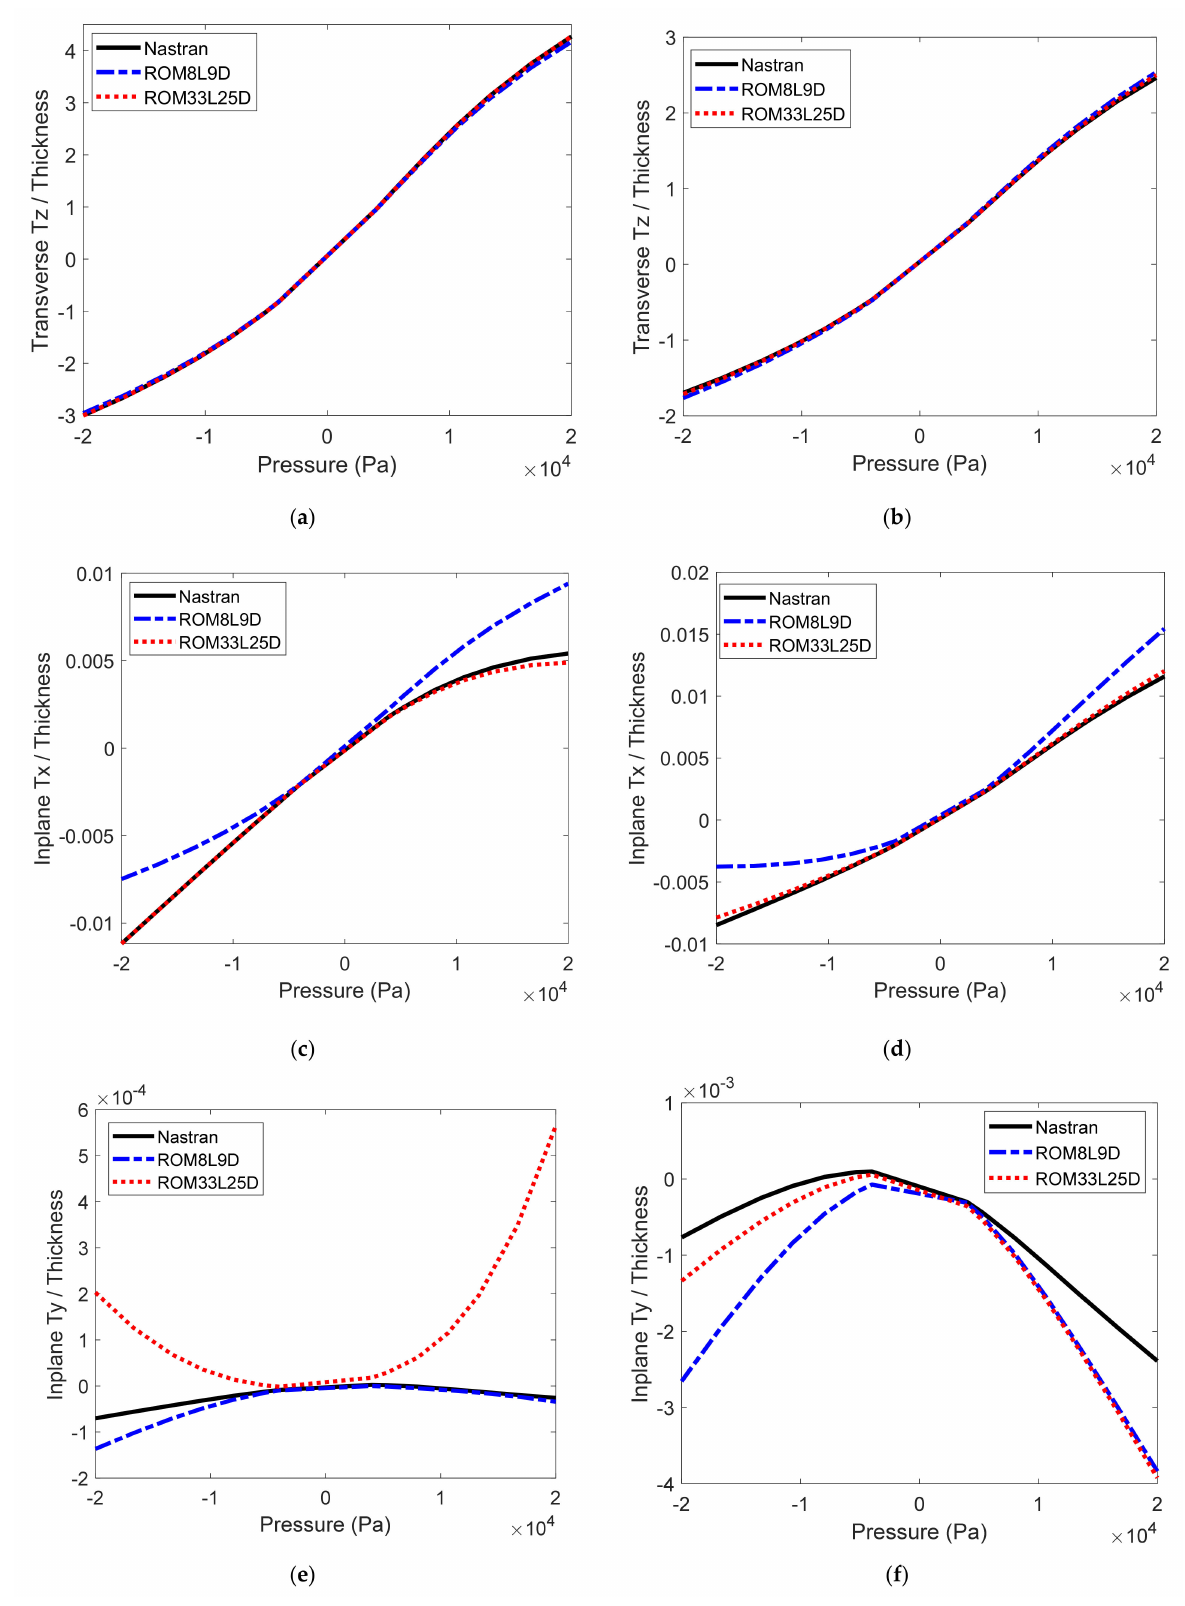
Figure 17. Static displacements induced by a left-right asymmetric pressure on the orthogrid panel. Predictions from Nastran, the 8L9D and 33L25D ROMs. ( a , c , e ) center point, ( b , d , f ) quarter point, displacements along ( a , b ) transverse z , ( c , d ) in-plane x , ( e , f ) in-plane y